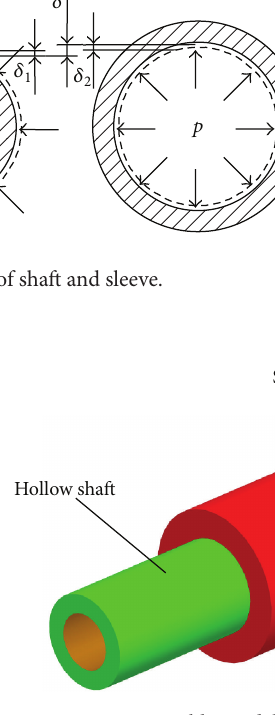
Figure 2: Assembly model of hollow shaft and